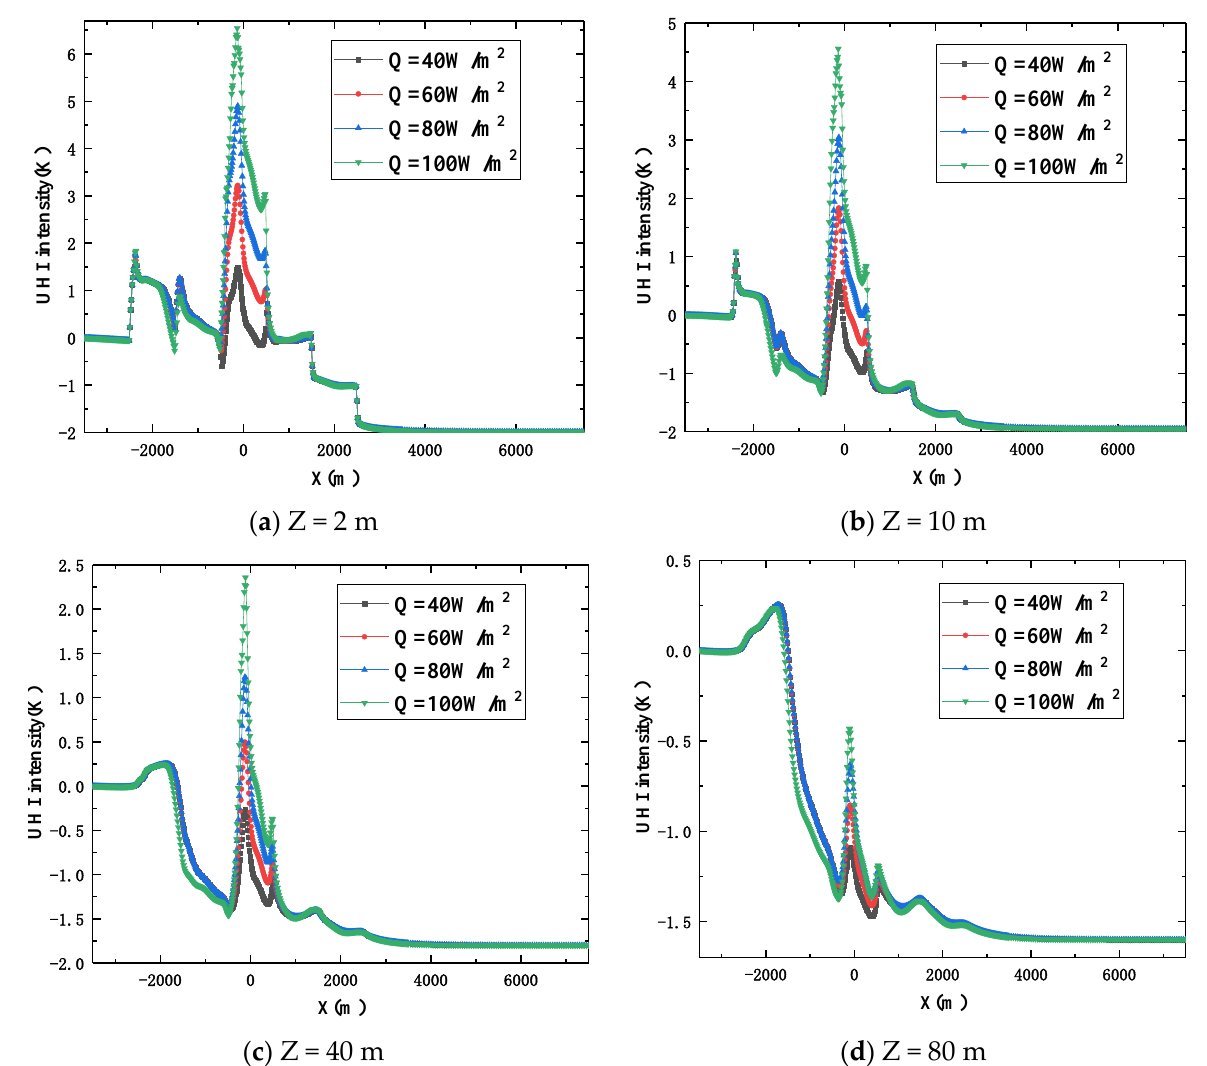
Figure 13. The horizontal profiles of the UHI intensities at different intensities of the artificial heat source at the heights of ( a ) 2 m, ( b ) 10 m, ( c ) 40 m, and ( d ) 80 m in plane y = 0. ( a ) 2 m, ( b ) 10 m, ( c ) 40 m, and ( d ) 80 m in plane y =